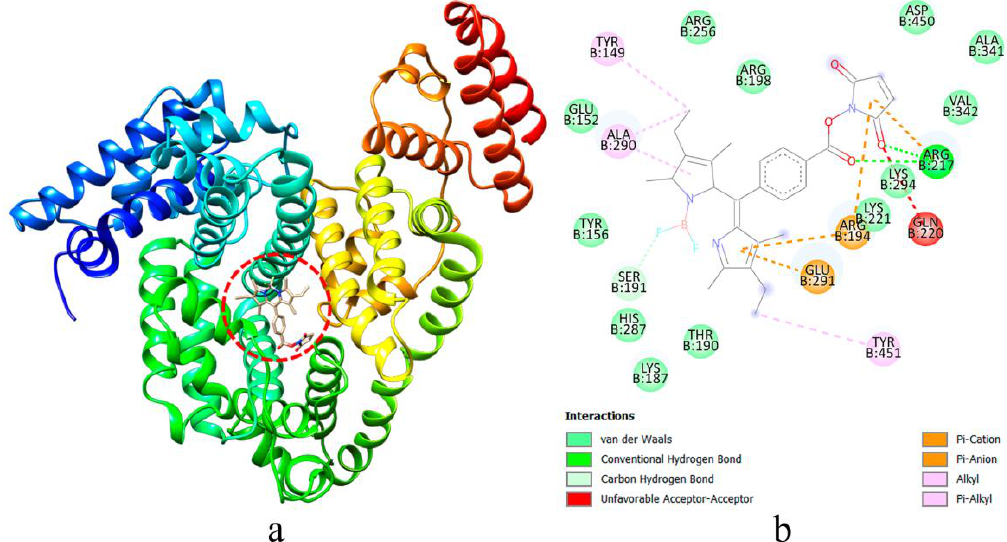
Figure 9. Binding site of NHS-Ph-BODIPY in BSA ( a ) and its amino acid composition ( b ) accord- ing to blind docking results.